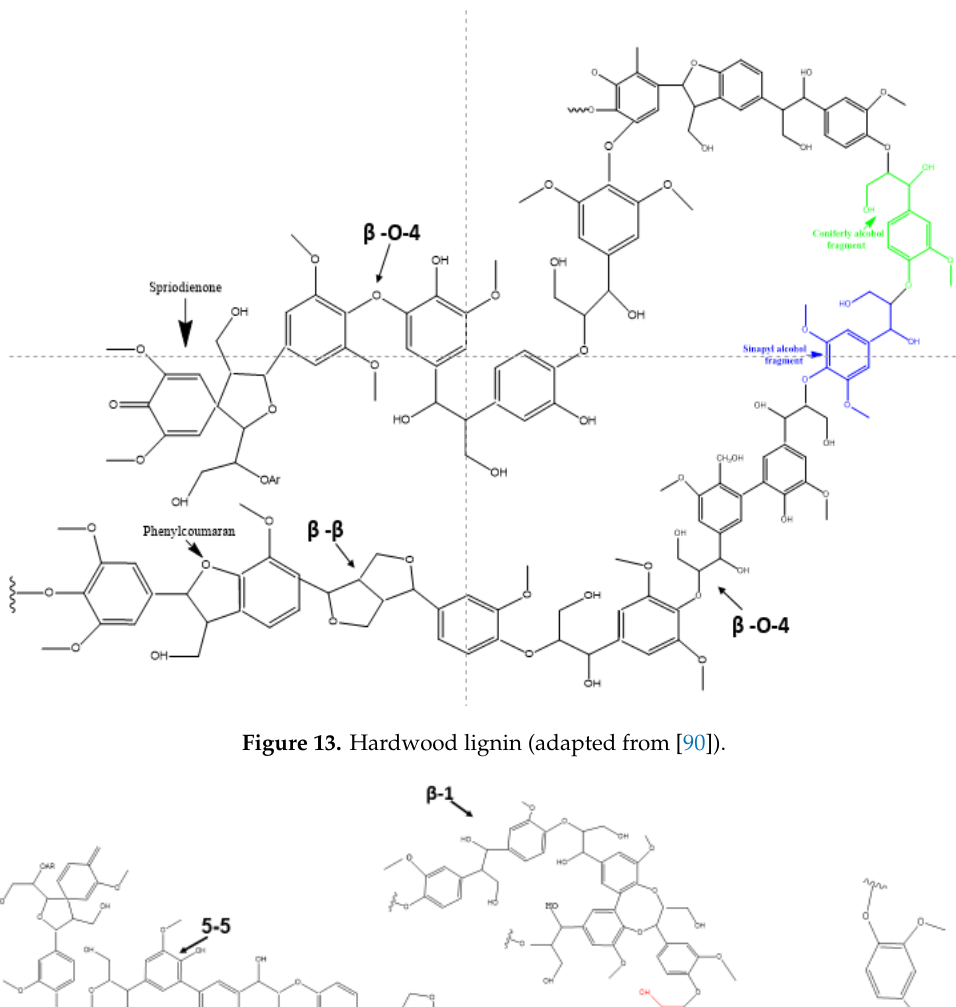
Figure 13. Hardwood lignin (adapted from [90]).